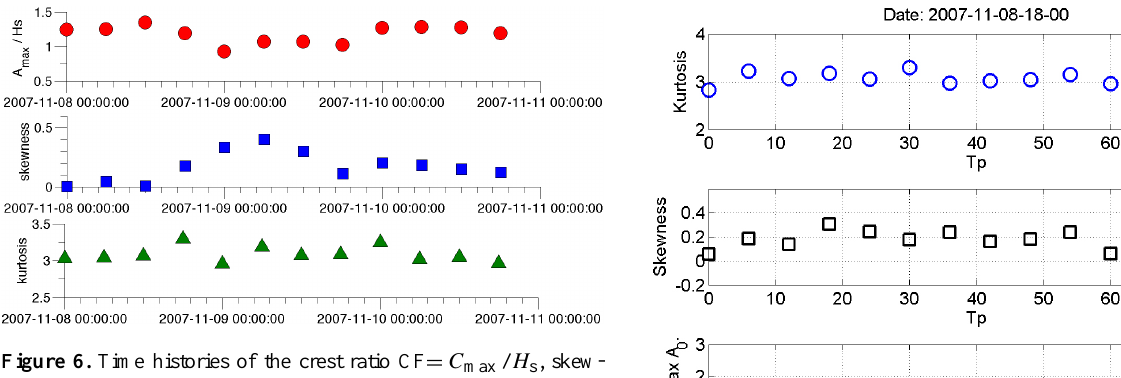
Figure 6. Time histories of the crest ratio CF = C max / H s , skew- ness and kurtosis in the period 8–11 November 2007 ( A max is the maximum amplitude equal to C max ) .